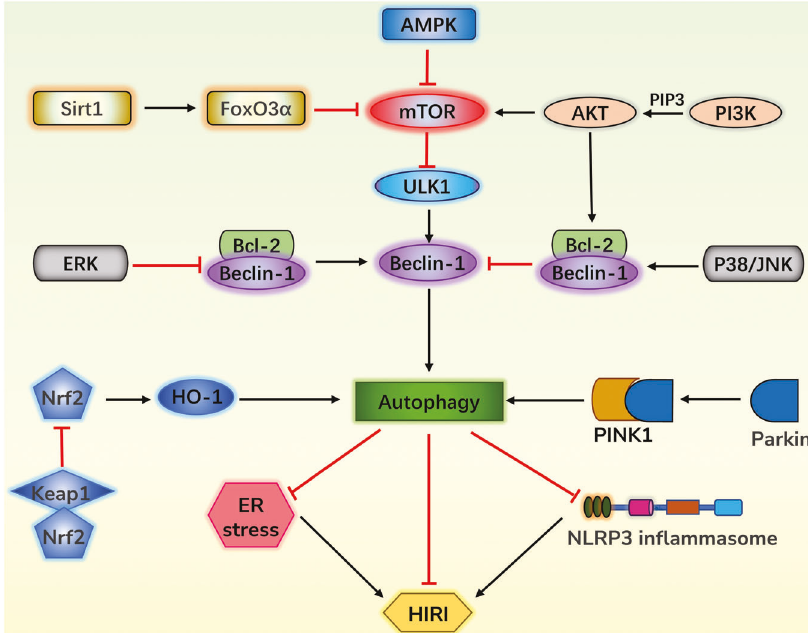
Fig. 3 Pathway network for autophagy to affect HIRI. MTOR is the hub of autophagy regulation. The AMPK pathway and Sirt-FoxO3 α pathway inhibit mTOR and thus activate autophagy, while the PI3K-AKT pathway activates mTOR and thus hinders autophagy. Beclin-1 is another key protein in the regulation of autophagy. ERK inhibits Bcl-2 and Beclin-1 binding and exerts autophagy activation, while P38 and JNK appear to exhibit opposite effects. The Nrf2/HO-1 pathway and the PINK1/Parkin pathway are also two important pathways that activate autophagy. Finally, activated autophagy can attenuate HIRI either directly or by inhibiting ER stress and suppressing NLRP3 in fl ammasome. AMPK adenosine 5 ′ -monophosphate-activated protein kinase, mTOR mammalian target of rapamycin, PI3K phosphoinositide 3-kinase, AKT protein kinase B, PIP3 phosphatidyl inositol-3,4,5-triphosphate, Sirt1 Sirtuin 1, FoxO3 α transcription factor, ERK extracellular signal-regulated kinase, JNK c-Jun N-terminal kinase, Nrf2 Nuclear factor erythroid 2- related factor 2, Keap1 Kelch-like erythroid-associated protein 1, Pink1, phosphatase and tensin homolog-induced putative kinase 1, Parkin an E3 ubiquitin ligase encoded by the gene Park2, NLRP3, nucleotide- binding domain leucine-rich repeat containing family pyrin domain containing